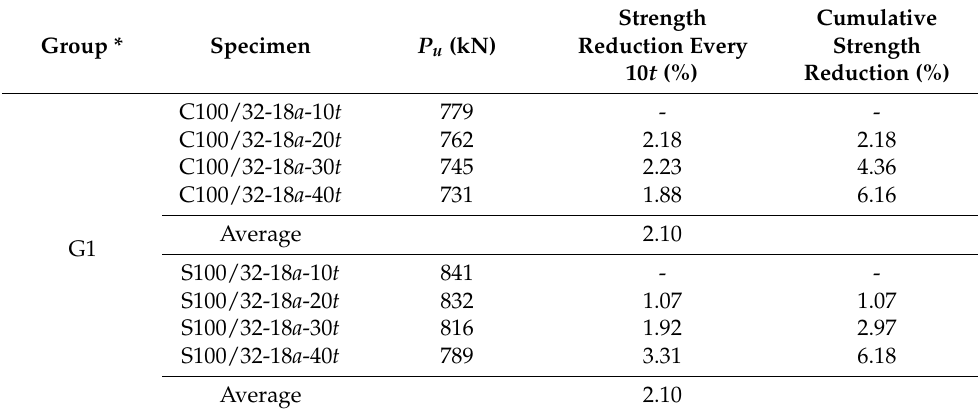
Table 6. Comparison of the 18 mm and 25 mm plate